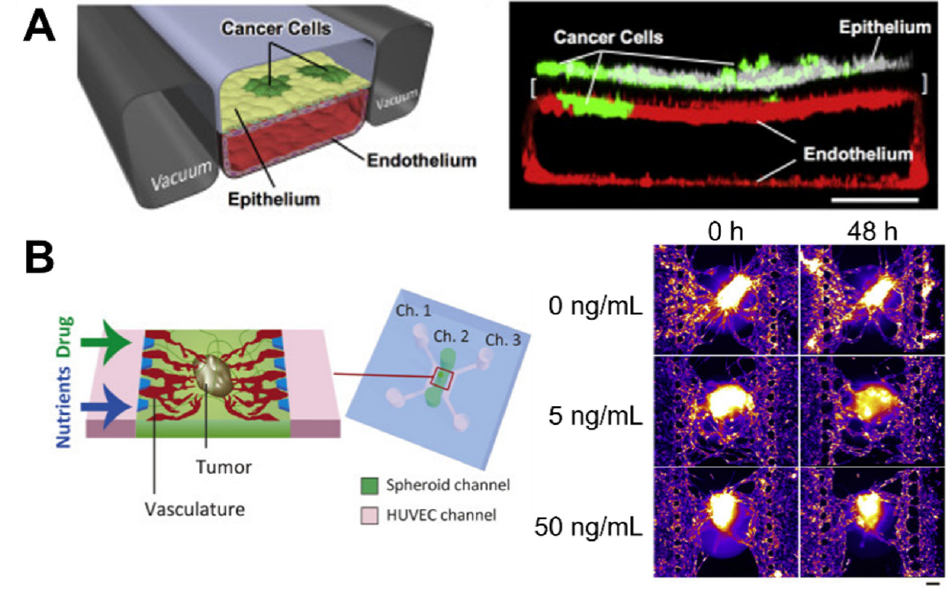
Figure 3. Microfluidic-based cancer-on-chip systems. ( A ) Lung cancer-on-a-chip system for the study of organ microenvironment-specific cancer behaviors, Reprinted with permission from ref. [82]. Copyright 2017 Elsevier. ( B ) Vascularized cancer-on-a-chip system for the evaluation of the effect of paclitaxel on cancer through the vasculature. Reprinted with permission from ref. [88]. Copyright 2020 Elsevier.